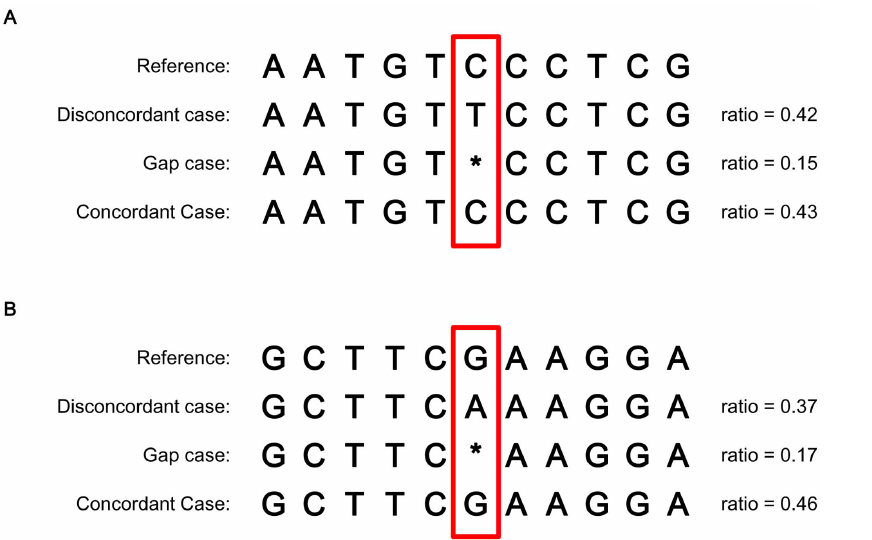
Figure 4. Neighboring bases pattern of a mismatch position. (A) 3-base-homopolymer neighboring bases appear at the reference. (B) 3-base- homopolymer neighboring bases appear at reads.